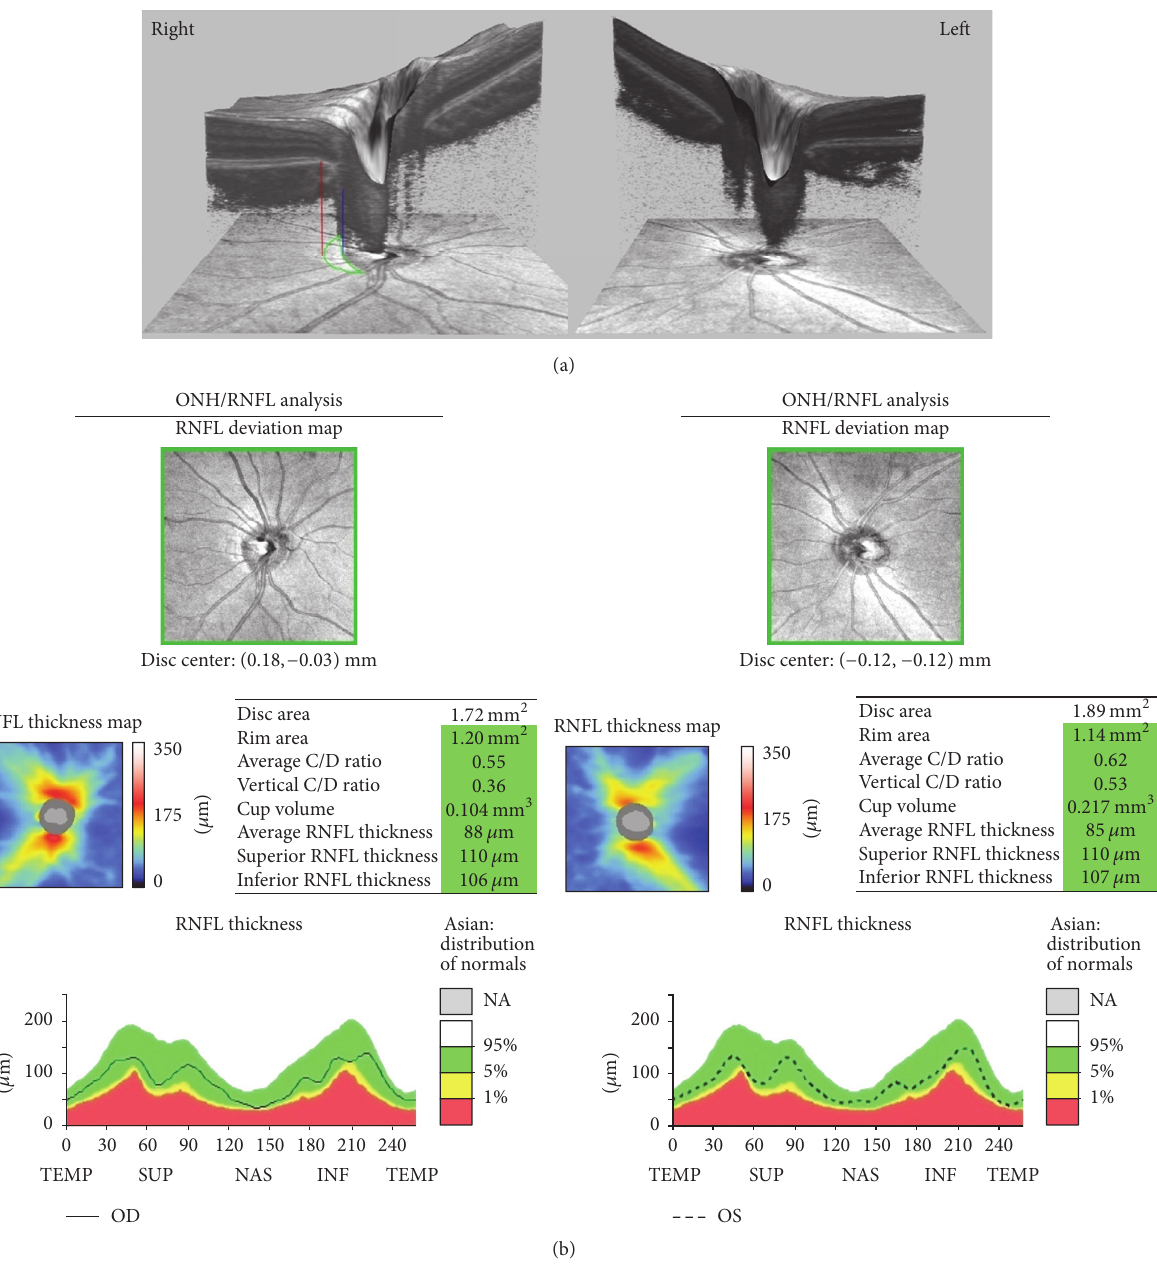
Figure 1: The optical coherence tomography (OCT) and optic nerve head (ONH) image of a 19-year-old female with prominent 𝛽 -zone parapapillary atrophy ( 𝛽 -PPA) in the right eye and no 𝛽 -PPA in the left eye. The spherical equivalent of refractive error was −4.75 diopters (D) in the right eye and −5.00 D in the left eye. (a) The en face and cross-sectional optic nerve head OCT images show sections of the 𝛽 -PPA area. The red line designates the end of the retinal pigment epithelium, and the margin of the 𝛽 -PPA and the blue line designate the optic disc margin. The area surrounded by the green line is the 𝛽 -PPA. (b) The OCT results of ONH parameters and peripapillary retinal nerve fiber layer